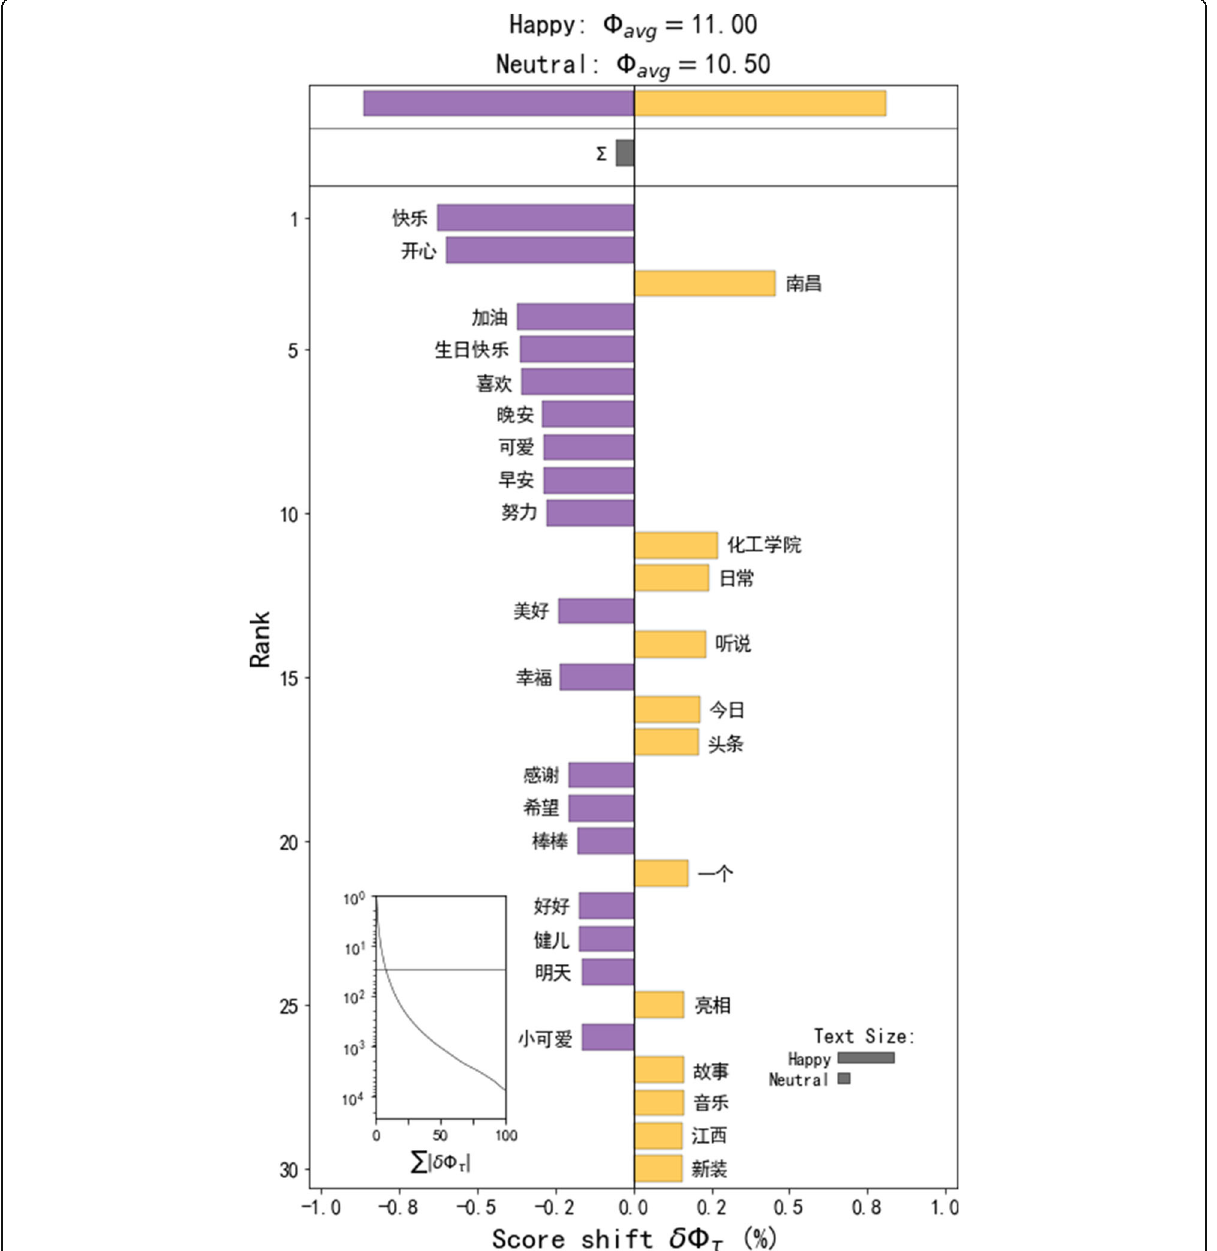
Fig. 4 Word shift graphs of the Weibos in the happy emotion hot